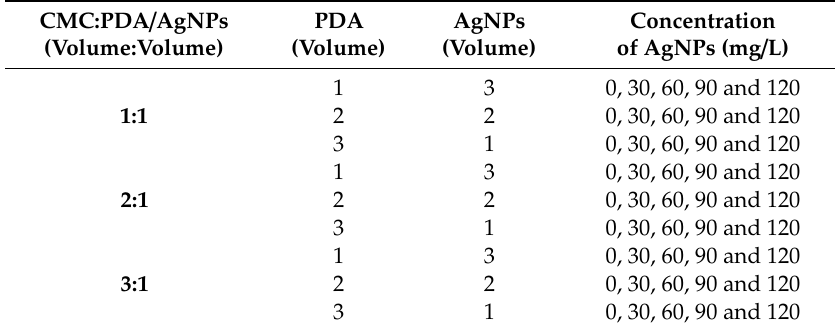
Table 1. The ratios of reagents [carboxymethyl cellulose (CMC) / Polydiacetylene (PDA) / Silver Nanoparticles (AgNPs)] examined in this